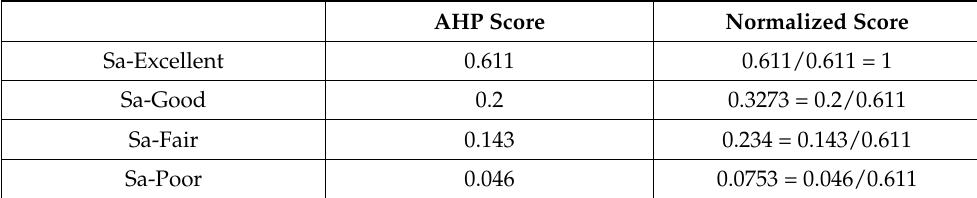
Table 11. AHP Score and Normalized Score for the Safety